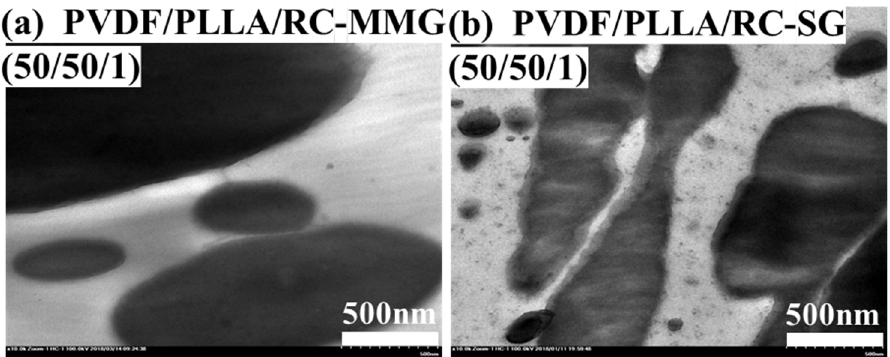
Figure 7. TEM images of PVDF/PLLA (50/50, w/w) blends with 1 wt.% RC–MMG ( a ) or RC–SG ( b ).